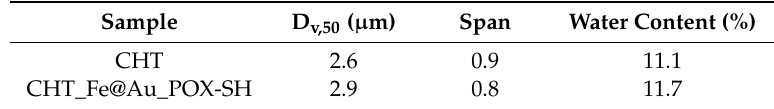
Table 1. Microparticle composition and properties.